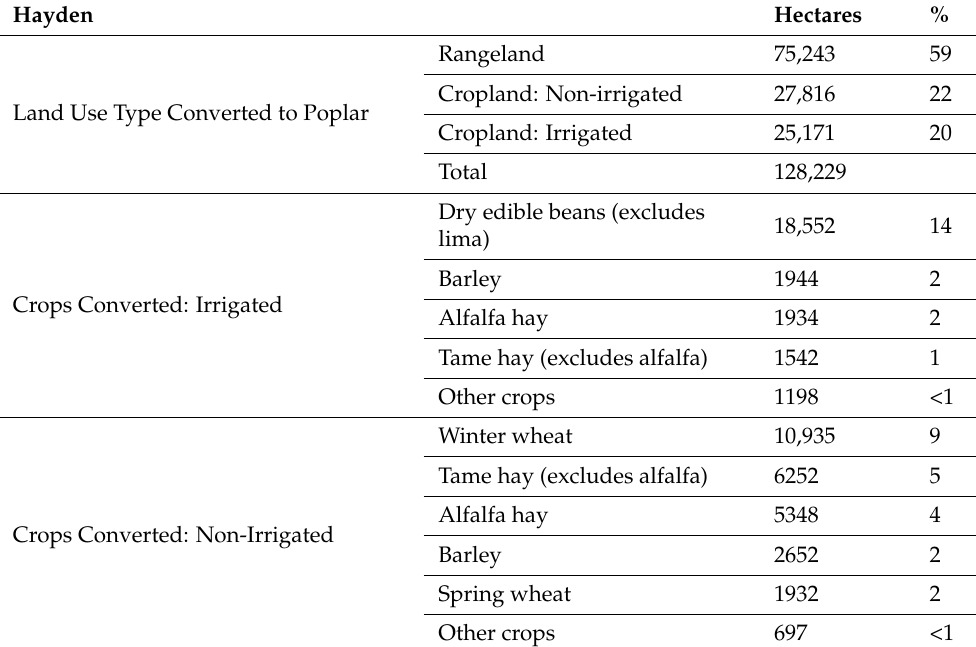
Table 4. Hayden land use and crop types converted to growing poplar. ‘Other crops’ are crops that individually represented less than 1% of the land used to grow crops. Percentage column is based on total land use types converted to growing poplar.